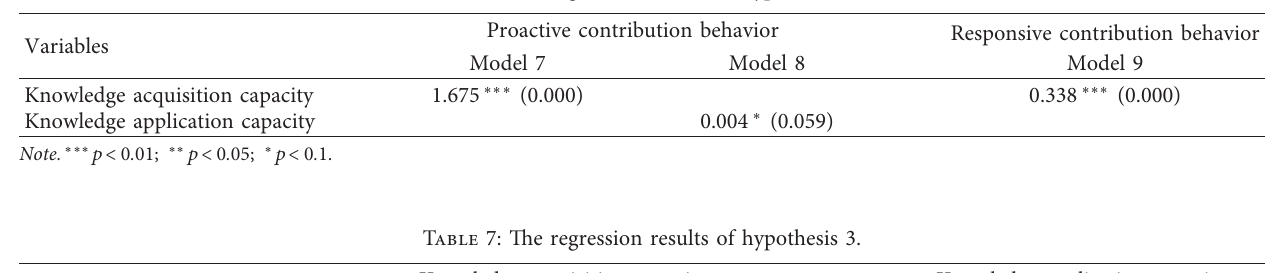
Table 6: The regression results of hypothesis 2.